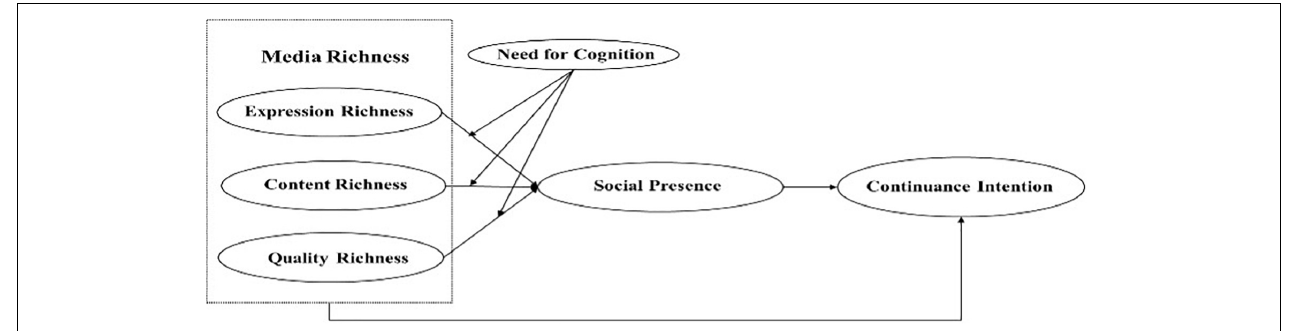
FIGURE 1 | Conceptual